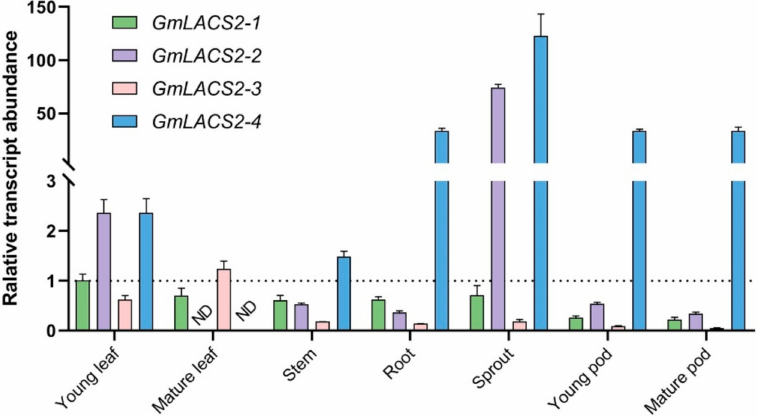
Figure 2. The expression patterns of different GmLACS2 transcripts in different parts of Glycine max